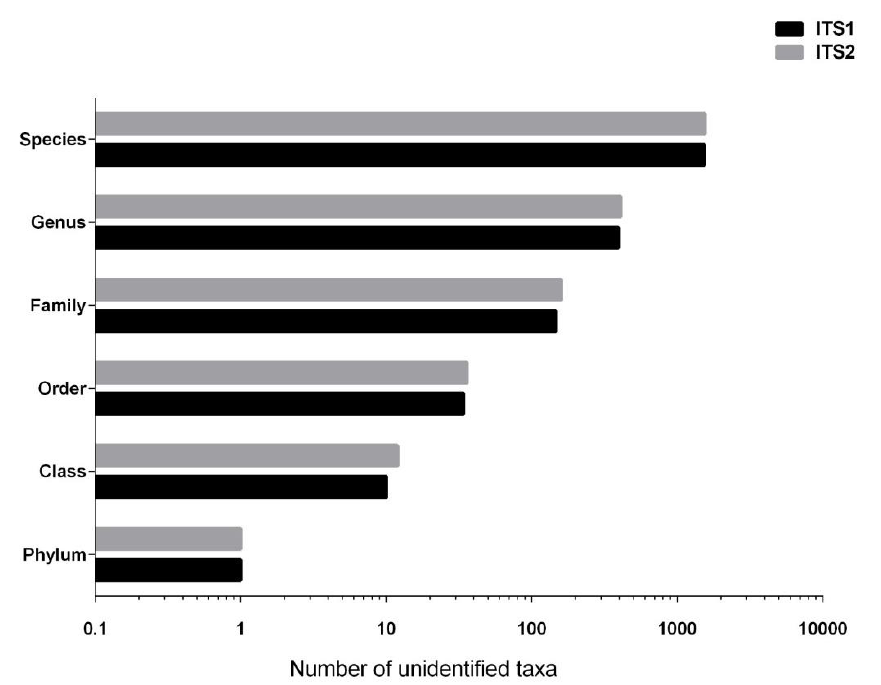
Figure 1. Number of unidentified taxa (sequences that could not be identified or that lack full species name) in all taxonomic level of the UNITE database. Data was separated according to the sequences retrieved with primers targeting ITS1 and ITS2.